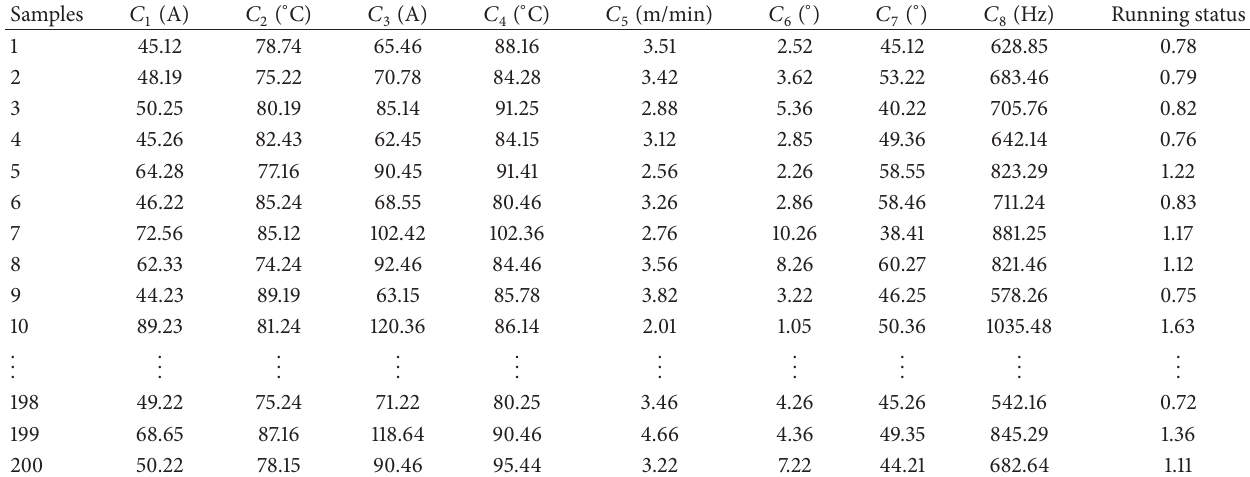
Table 1: The running status of shearer and its corresponding parameters.